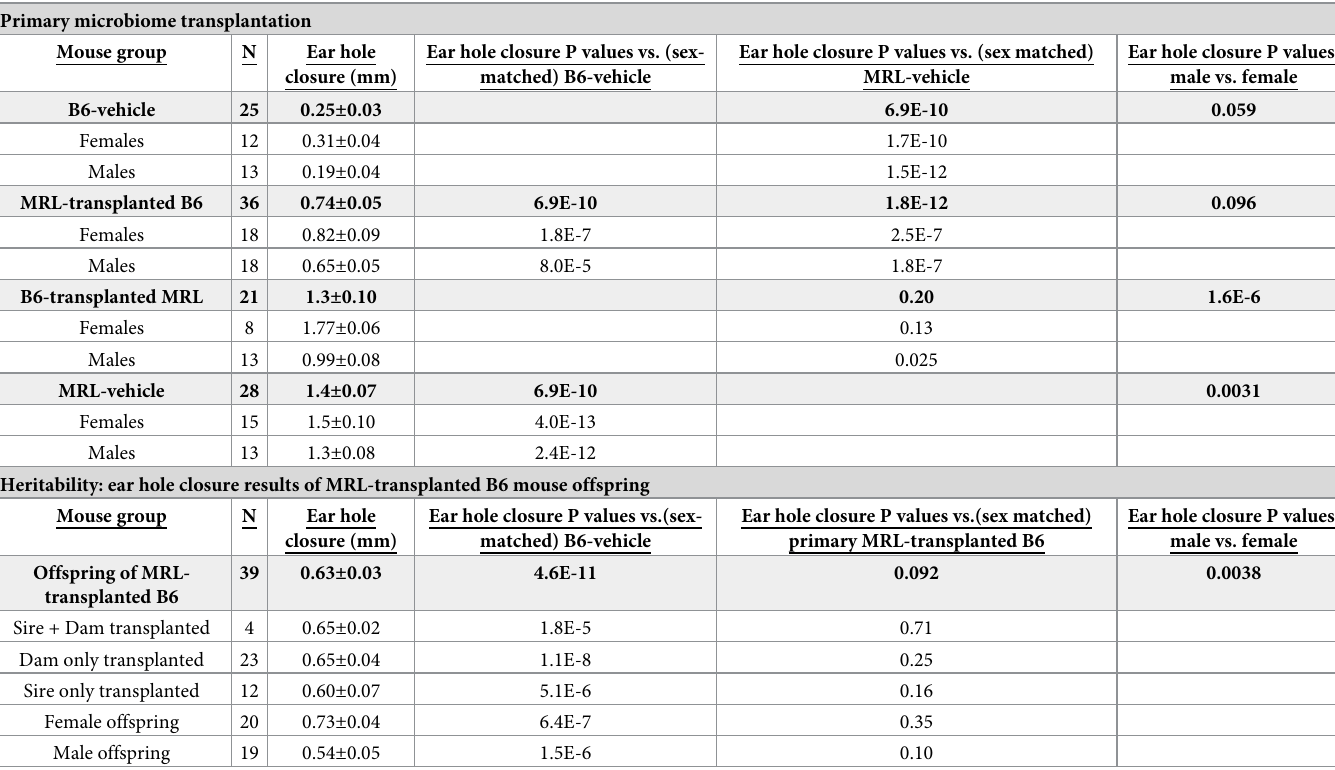
Table 1. Ear hole closure under various cecal transplantation